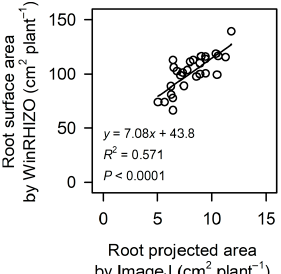
Figure 4. A linear correlation between root projected area measured non-destructively on rhizotron images with ImageJ software and root surface area measured destructively on washed-root images with WinRHIZO software in soybean seedlings. All images were collected at 18 days after sowing. Treatments were as described in Table 1.